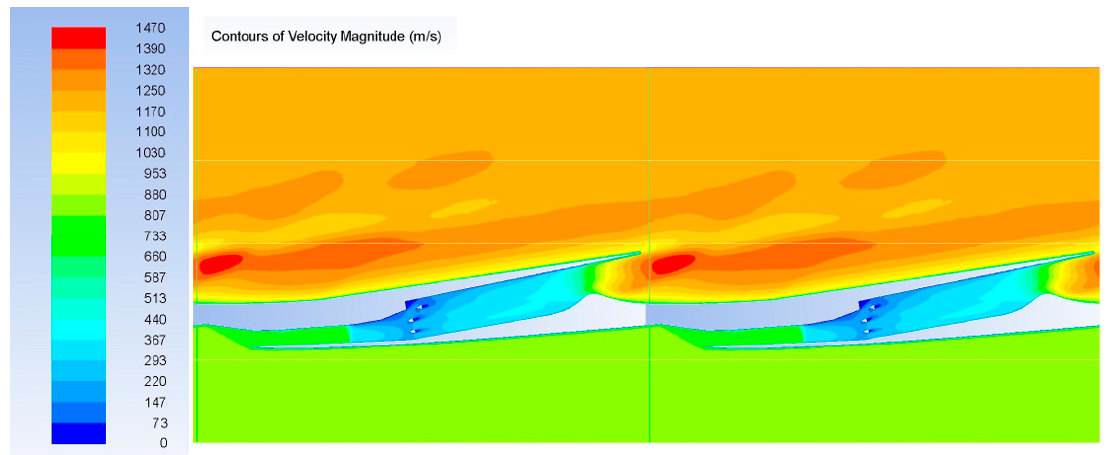
Figure 16. Distribution of the flow velocity (m/s) relative to the single-rotor engine ( M = 2.5).